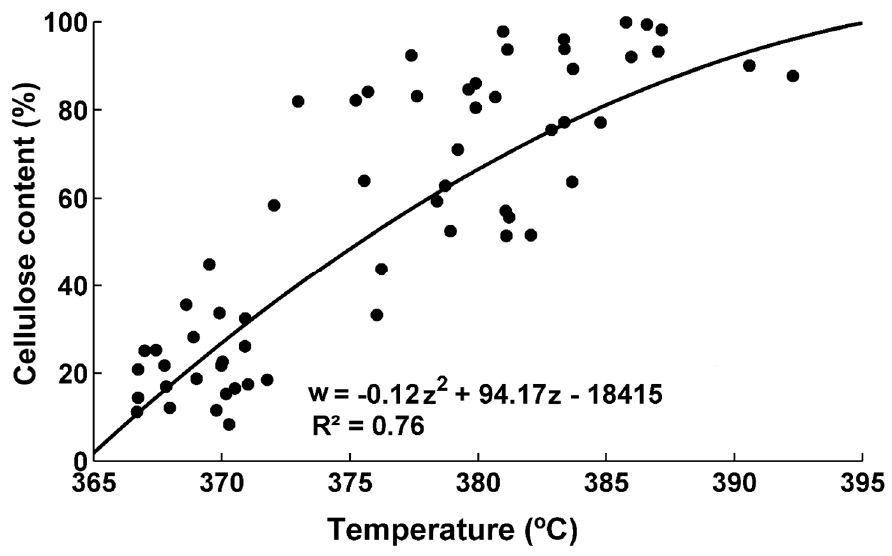
Figure 13. Cellulose content as a function of the peak temperature in the region from 300 to 400 °C.